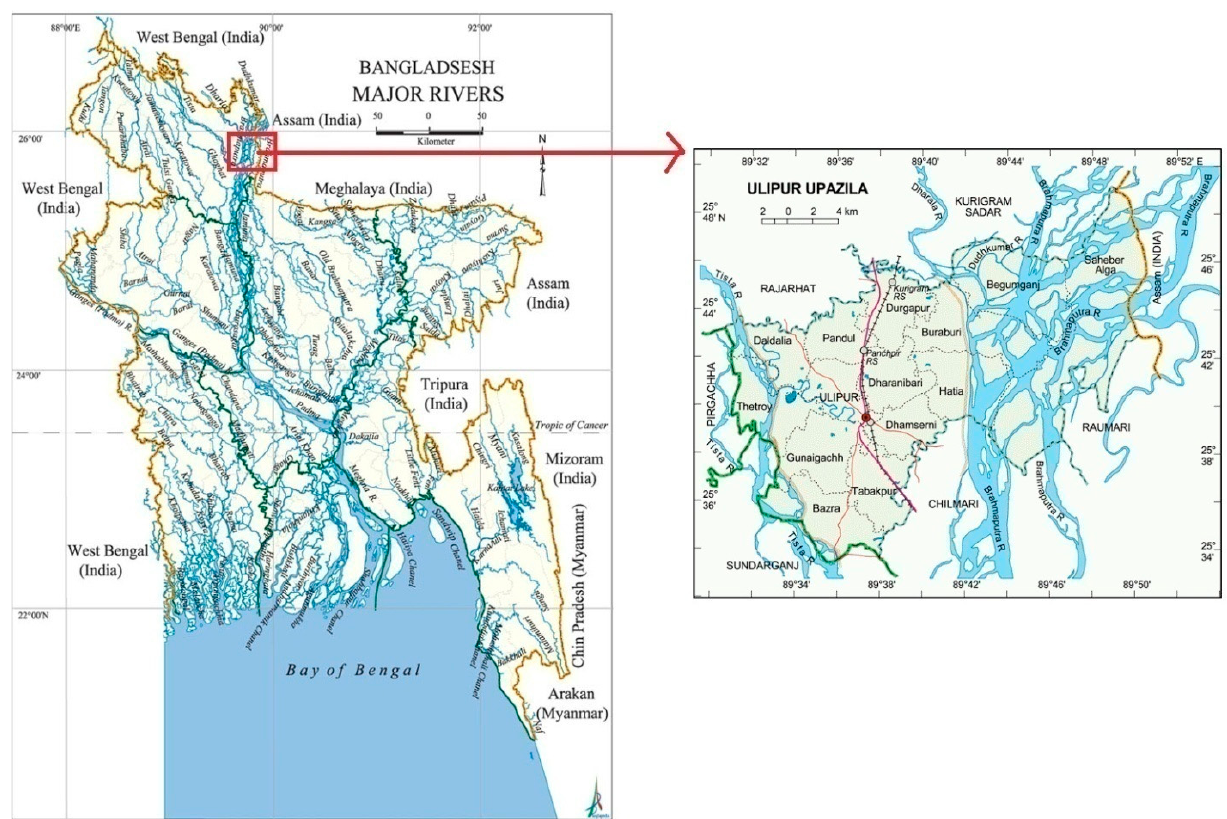
Figure 2. Hydrological system of Bangladesh and the location of the study area.